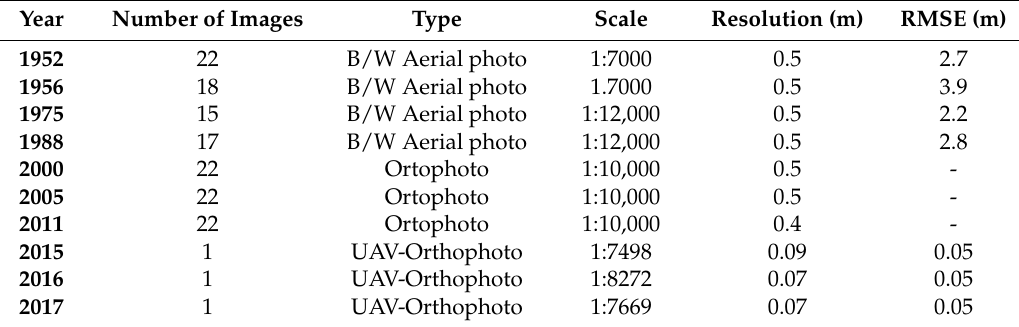
Table 1. Basic parameters of aerial imagery and orthophotographs used in this study.